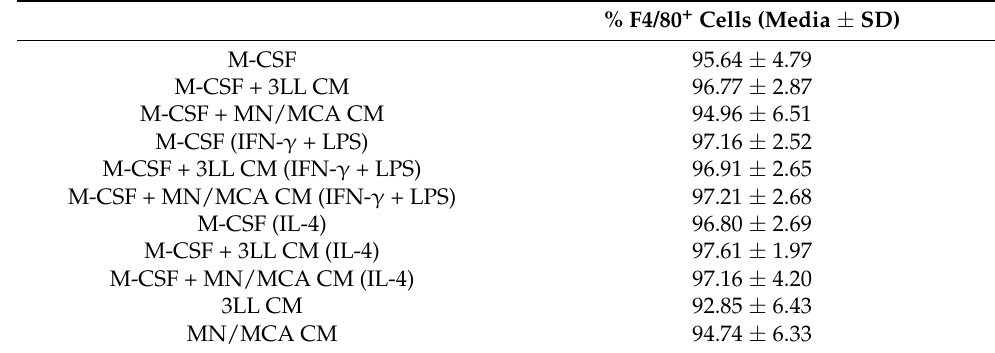
Table 1. Percentage of F4/80 + cells after differentiation and polarization of bone marrow precursor cells (day 7). Data show media ± SD of 4 independent